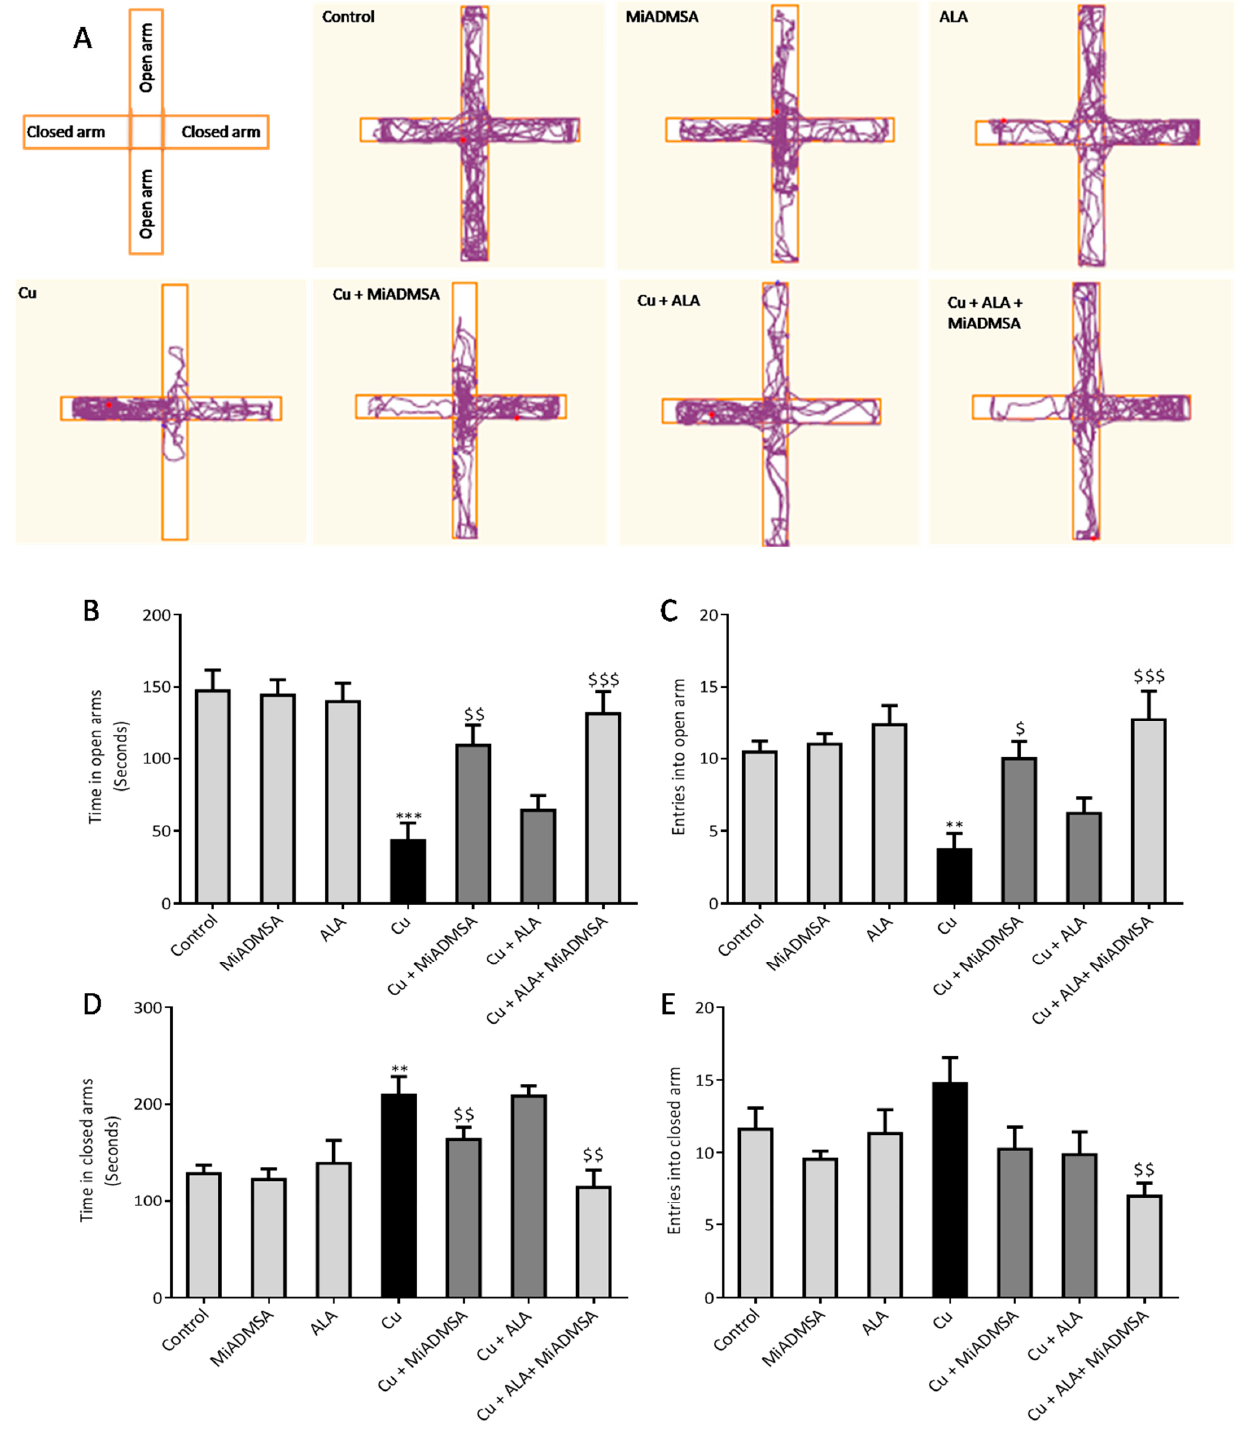
Figure 9. The combination therapy with MiADMSA and ALA improved the elevated plus-maze performance. ( A ) Tracking graphs; ( B ) Time in open arms; ( C ) Entries into open arms; ( D ) Time in closed arms; ( E ) Entries into closed arms. All the values are expressed as mean ± S.E.M. ( n = 6) * p < 0.05, *** p < 0.001 vs. control and $ p < 0.05, $$ p < 0.01 vs. Cu. $$$: It indicates the comparison between the groups which we have mentioned in the figure legends. **: It indicates the comparison between the groups which we have mentioned in the figure